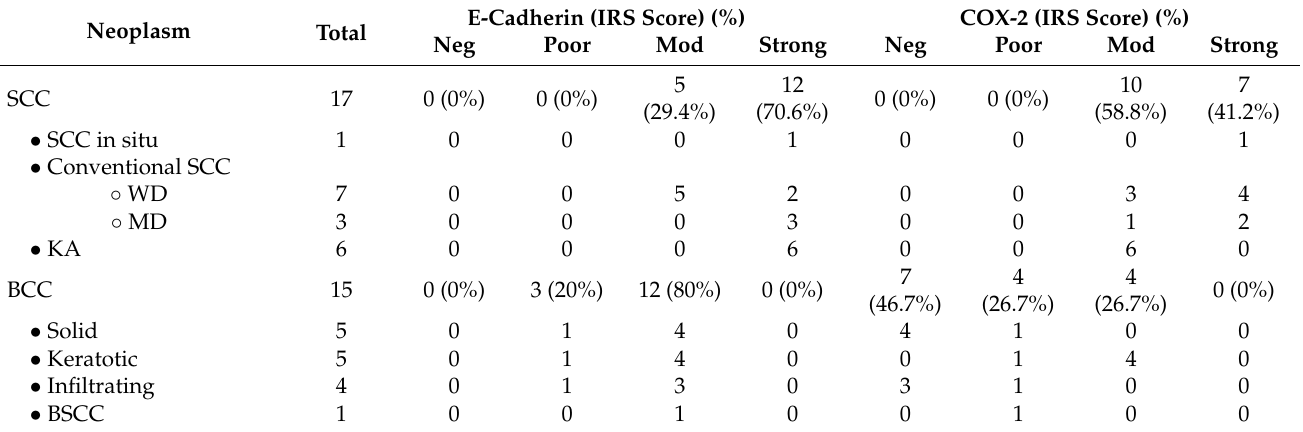
Table 4. Expression of E-Cadherin and COX-2 according to the IRS score system (0–12) in 17 squamous cell carcinomas (SCCs) and 15 basal cell carcinomas (BCCs) from squamate and chelonian species.